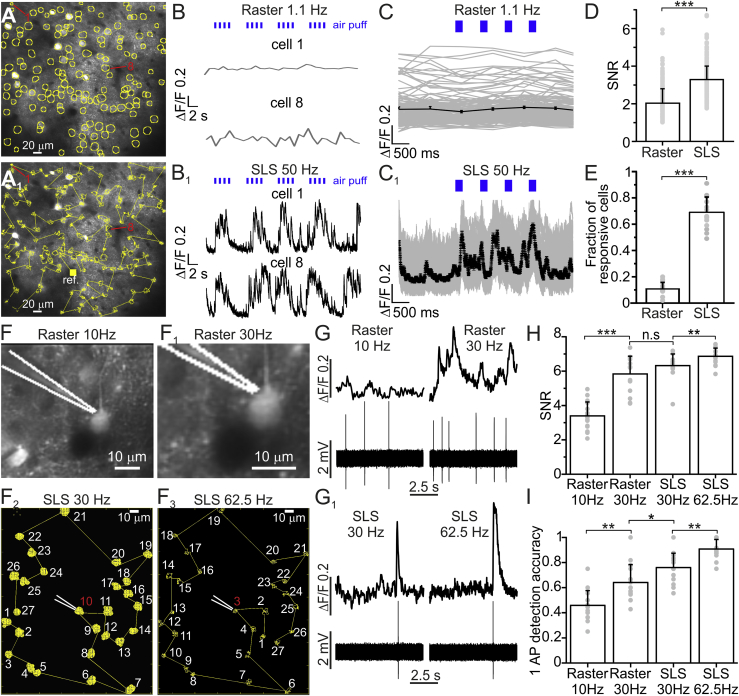
SLS Allows Single AP Resolution during Population Imaging(A) GCaMP6s-expressing layer IV principal neurons. Yellow circles identify 155 neurons. (A1) SLS trajectory (yellow line) crossing all the identified cells.(B and B1) Fluorescence over time from the two cells indicated in red in (A) in conventional raster scanning acquisitions (B) and SLS (B1). Blue ticks above traces indicate whisker stimuli (duration: 200 ms).(C and C1) Fluorescence over time of all cells shown in (A) (gray traces) during consecutive whisker stimulations and the average across cells (black trace) in raster scanning (C) and SLS (C1).(D) SNR of events in all raster scan series and all SLS acquisitions. n = 360 cells from 4 animals; paired t test, p = 5E-4.(E) Fraction of cells responding to the whisker stimulation in raster scanning and SLS. n = 360 cells from 4 animals; paired t test, p = 4E-12.(F–F3) Simultaneous juxtasomal recording and raster scan experiment from a GCaMP6s-expressing neuron at 10 Hz (F) and 30 Hz (F1). The white line indicates the recording pipette. The same cell in (F) is recorded using juxtasomal recording and SLS imaging in a much larger FOV at 30 Hz (F2) and 62.5 Hz (F3). The yellow line in (F2) and (F3) represents the SLS trajectory across the different cells (white number). The same cells were differently numbered in SLS at 30 Hz and 62.5 Hz because the SLS trajectory changed when the surround region was modified to change the scanning rate.(G) Left: fluorescence over time acquired in raster scanning at 10 Hz (top) and electrophysiology recording (bottom). Right: fluorescence over time acquired in raster scanning at 30 Hz (top) and electrophysiology recording (bottom).(G1) The same as in (G) for SLS at 30 Hz (left) and at 62.5 Hz (right).(H) SNR of fluorescence events associated to isolated APs (see STAR Methods) under the different conditions. n = 16 acquisitions from 8 FOVs in 4 animals; Wilcoxon rank-sum test; p = 5E-4 for raster scan at 10 Hz versus raster scan at 30 Hz; p = 0.12 for raster scan at 30 Hz versus SLS at 30 Hz; p = 7E-3 for SLS at 30 Hz versus SLS at 62.5 Hz.(I) Accuracy of single AP detection under the different conditions. n = 16 acquisitions from 8 FOVs in 4 animals; Wilcoxon rank-sum test; p = 2E-3 for raster scan at 10 Hz versus raster scanning at 30 Hz; p = 0.01 for raster scan at 30 Hz versus SLS at 30 Hz; p = 2E-3 for SLS at 30 Hz versus SLS at 62.5 Hz.